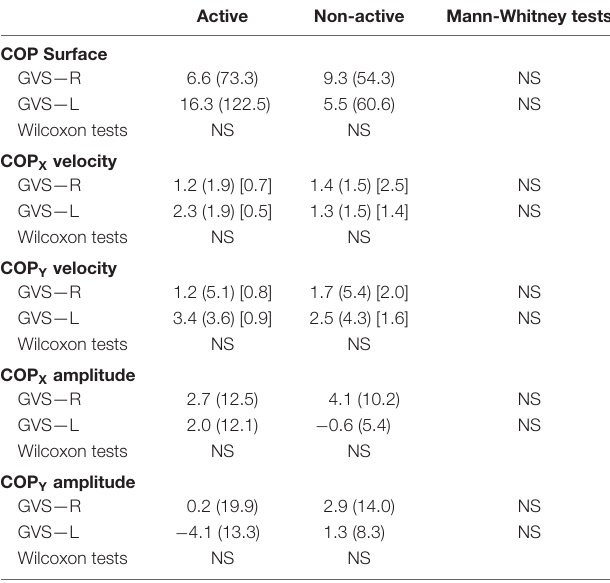
TABLE 2 | Absolute increase medians (IQR) of the center of foot pressure displacements parameters of the galvanic vestibular stimulation (GVS) conditions from the reference condition for the active and non-active